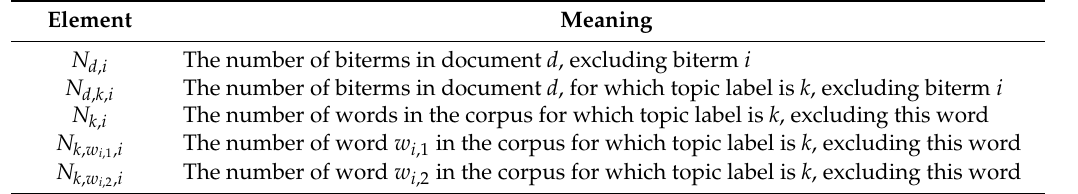
Table 1. The meaning of each element in Equation (2).